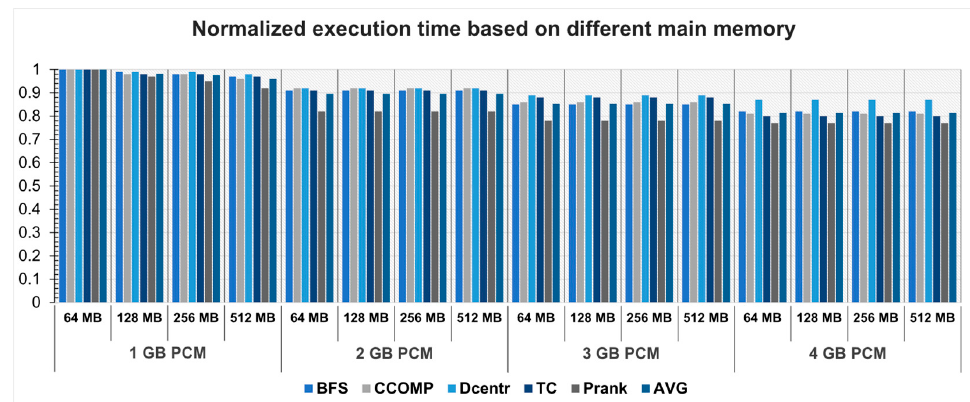
Figure 7. Execution time for different main memories.